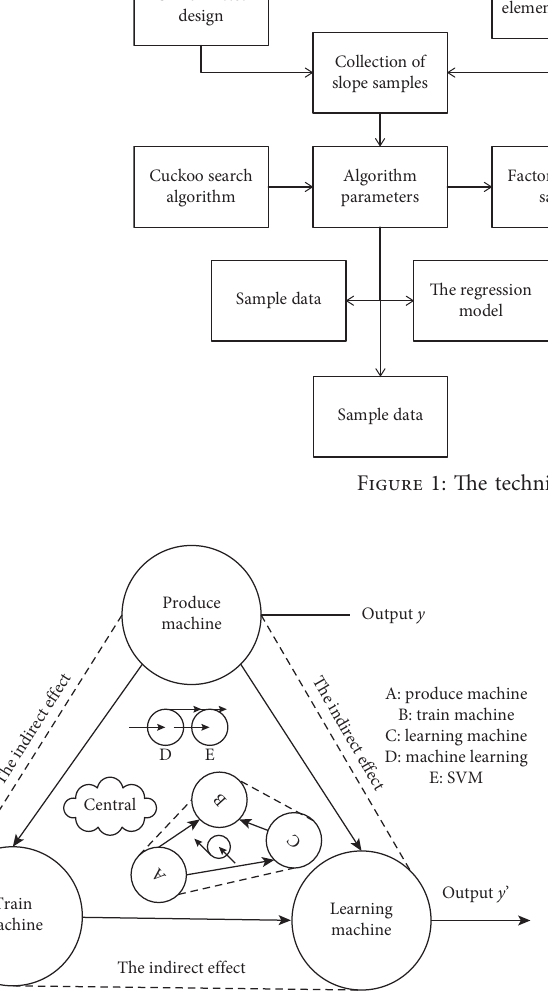
Figure 2: A prediction as possible for the unknown samples of the